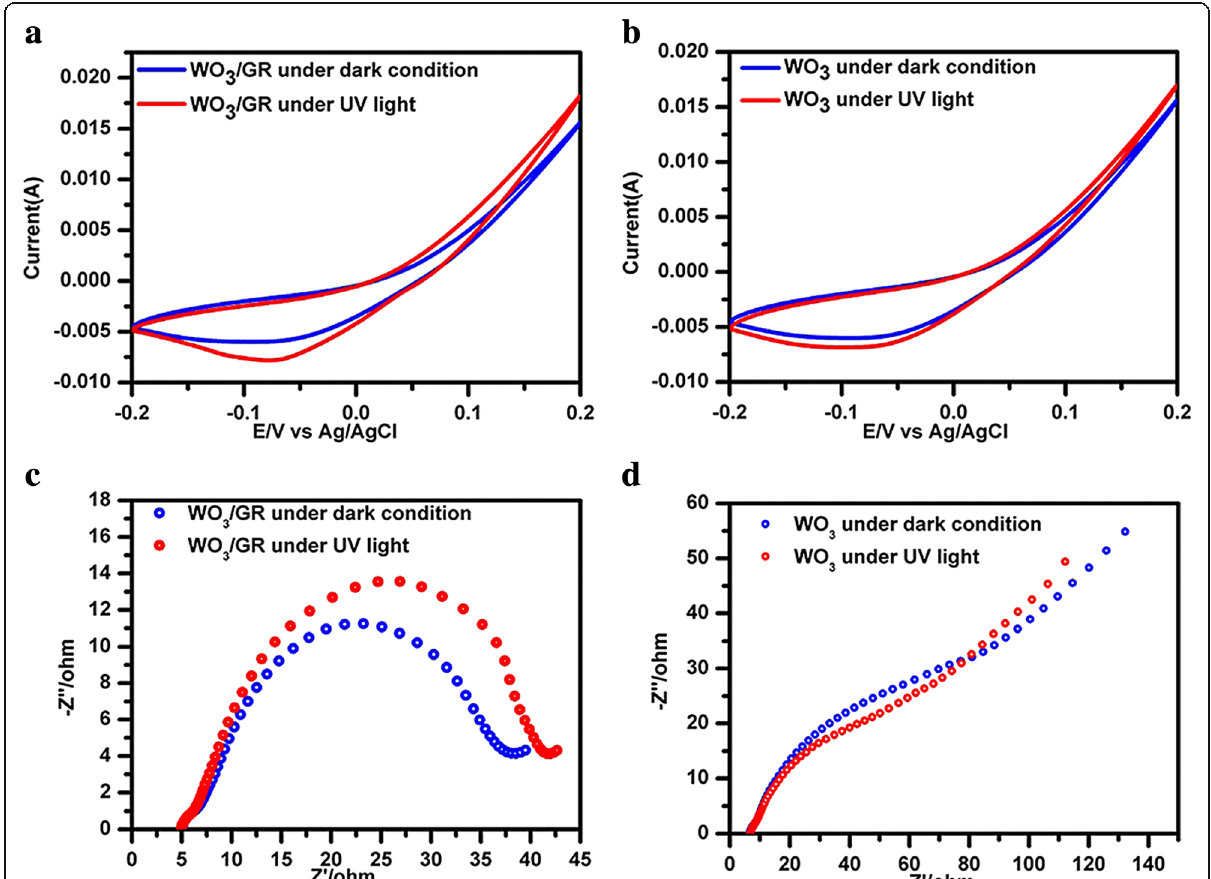
Fig. 4 Electrocatalytic application of CVD synthesized layered materials WO 3 /GR and WO 3 . a , b CV curves of as-grown WO 3 /GR, WO 3 on Cu foil. c , d electrochemical impedance spectra of WO 3 /GR, WO 3 flakes as well as the Cu foil